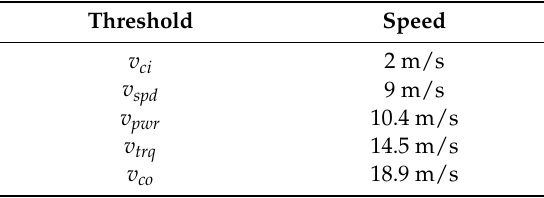
Table 4. Wind speed subregion